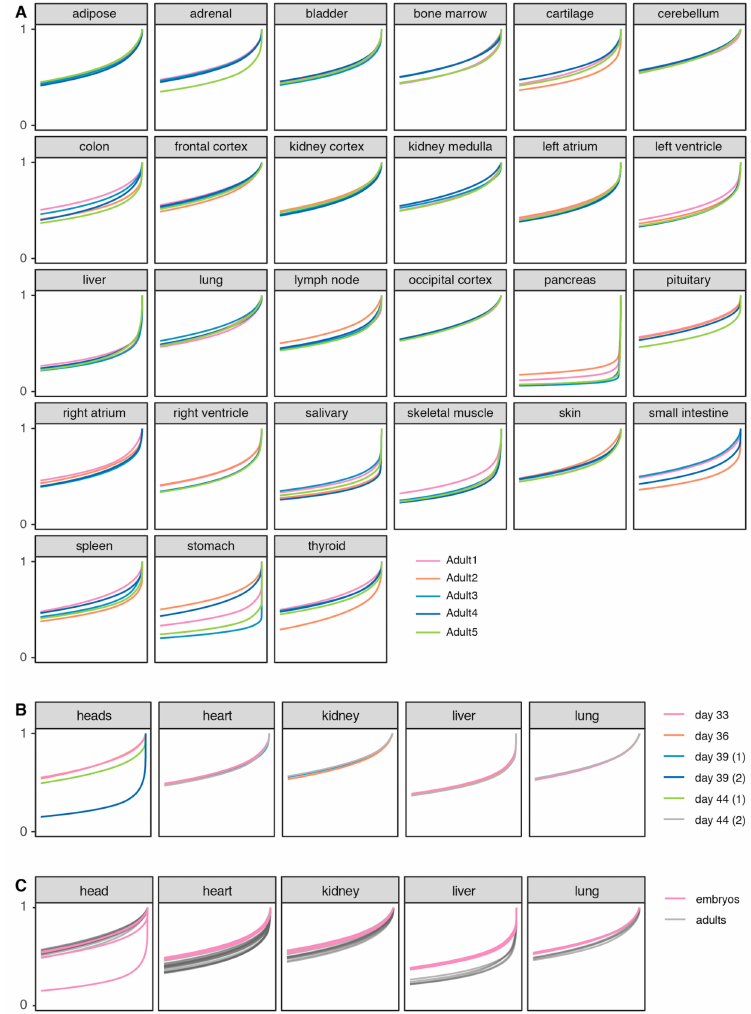
Figure 4. Cumulative transcriptome expression is matched to tissue type. Cumulative sum of fraction of tissue-specific transcriptomes represented by individual genes in ( A ) canine embryos at four gestational time points; and ( B ) up to five individual adult dogs. Single-gene counts per million (CPM) values were divided by sample-sum CPM, sorted in increasing order, and the cumulative sum calculated. Cumulative values are shown for the 1000 top-expressed genes in each sample. Data sampled from a given embryonic tissue at di ff erent gestational time points are very similar, perhaps reflecting the fairly narrow time window of sampling. Combining data from adult and embryonic samples ( C ) reveals strong similarity of data from given tissue types across individuals and developmental